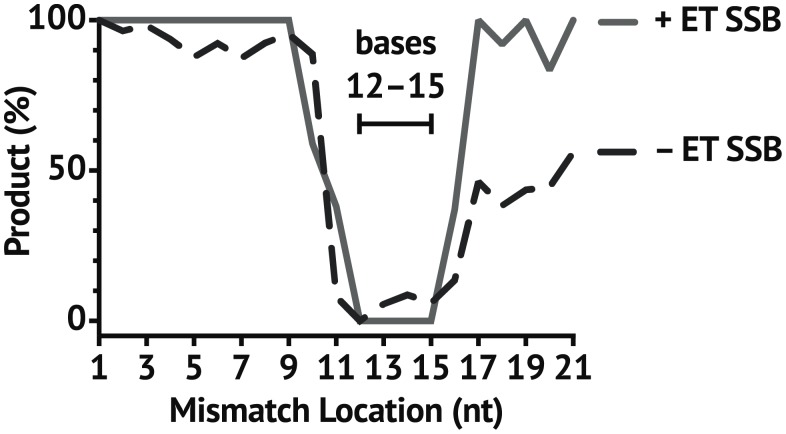
Effect of ET SSB on single-nucleotide mismatches within the guide.ET SSB increased TtAgo sensitivity to mismatches in specific locations. ET SSB generally increased the trend of TtAgo sensitivity to mismatches falling within the 12–15 region of the guide (supplementary region). Mismatches in the tail region had more of an inhibitory effect in the absence of ET SSB, and mismatches in the seed region had minimal effect on whether or not substrate was cleaved both with and without ET SSB. Percent product was determined as the ratio of product to substrate monitored by CE following incubation at 73 °C for 1 hr.